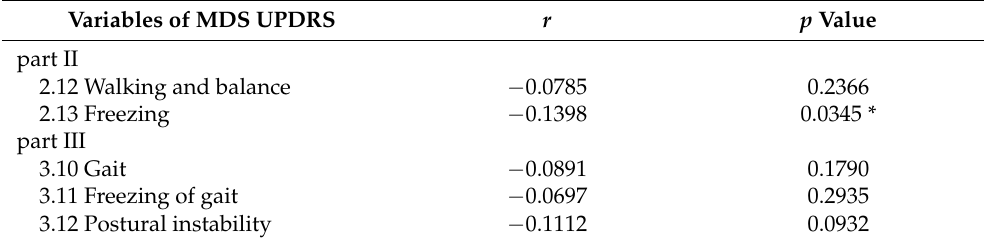
Table 6. Correlation between MDS UPDRS items regarding gait and posture with UPSIT, n = 229.